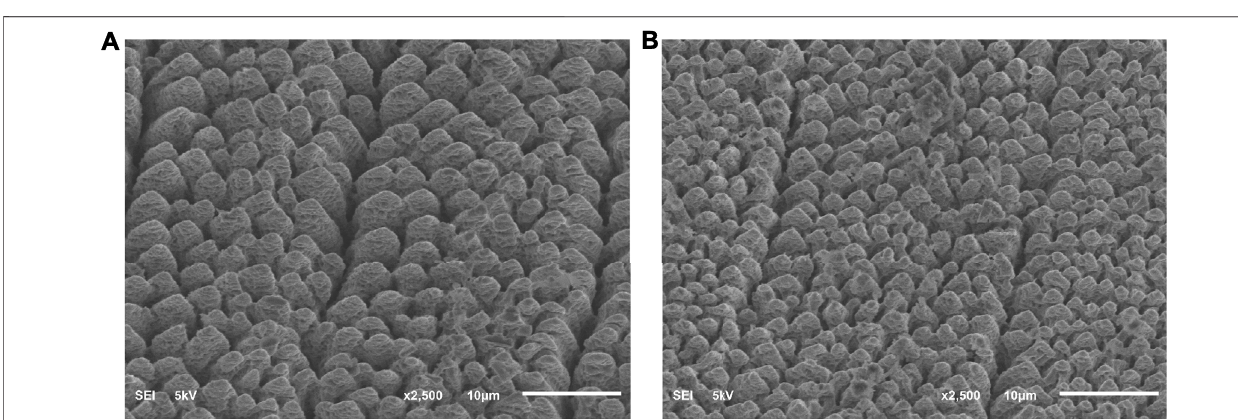
FIGURE 4 | Surface morphology processed (A) without laser cleaning and (B) with laser cleaning.